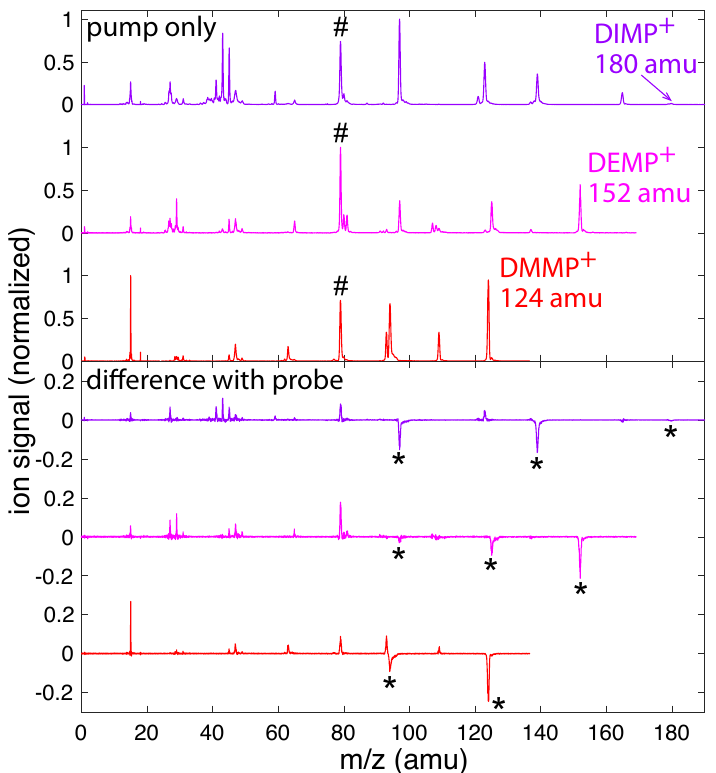
Figure 1. ( Top ) Mass spectra of DMMP (red), DEMP (magenta), and DIMP (violet) taken with only the pump pulse; and ( Bottom ) difference between pump-only mass spectra and mass spectra taken with the probe pulse at a delay of τ = 100